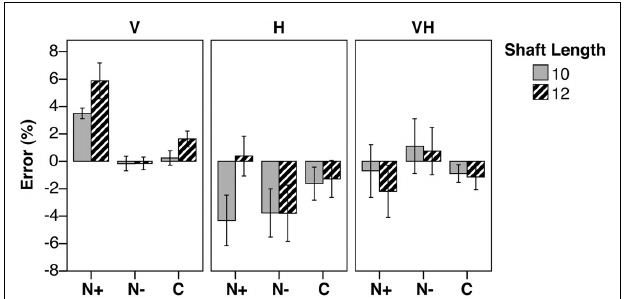
FIGURE 4 | Illusory effects. Mean percent error ( ± SEM) in shaft bisection in the illusory conditions, by Stimulus type (leftward outgoing/rightward ingoing, and leftward ingoing/rightward outgoing fins), Group (N + , N − , C), and presentation Modality (V, H,VH). Negative/positive score: leftward/rightward